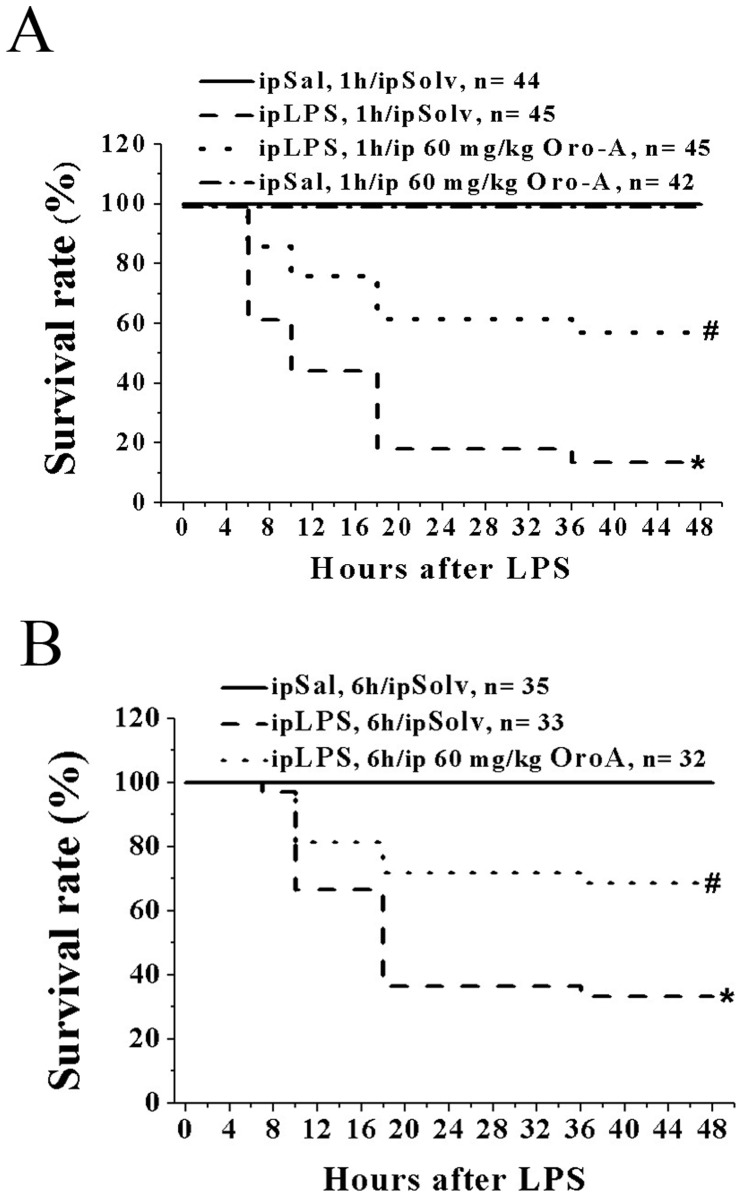
OroA improved the survival rate of endotoxemic mice.LPS treatment (100 mg/kg, ip) significantly decreased the survival rate in B6 mice (Panel A and B). The decrease was prevented by Oro-A (60 mg/kg, ip) administered 1 hr (Panel A) or 6 hrs (Panel B) after LPS challenge. Mice received Sal followed by Solv (ip) and Sal followed by OroA (60 mg/kg, ip) served as controls. *P<0.05 and #P<0.05 indicate significant difference from the control (Sal followed by Solv) group and LPS followed by Solv group, respectively. n indicates the number of experiments.